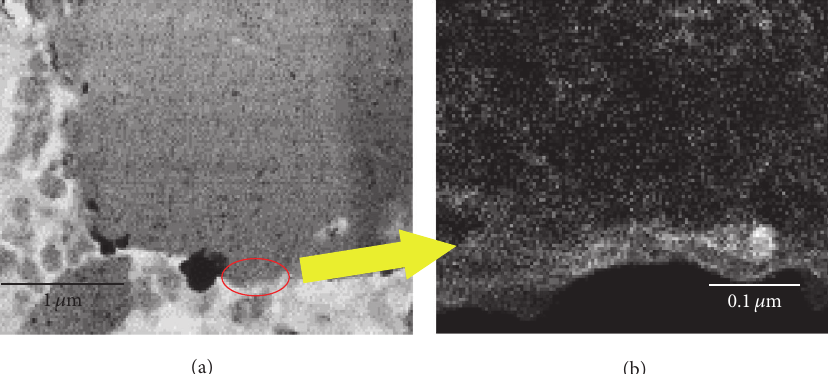
Figure 7: (a) STEM bright field image of the composite and (b) EELS map of the distribution of oxides in the composite for the area in the red circle in (a).